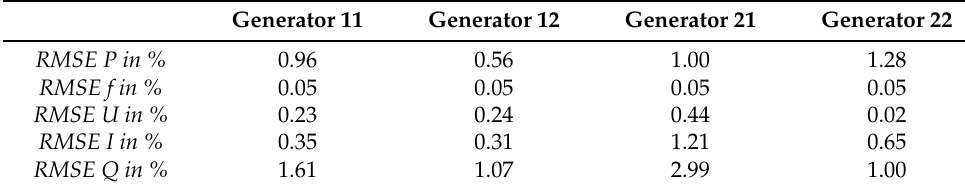
Figure 11. Measured (black) and simulated (red) signals (active Power P , frequency f , terminal voltage U , phase current I and the reactive power Q ) of the the four synchronous machines after the event. Table 5. RMSE in % of the signals displayed in Figure